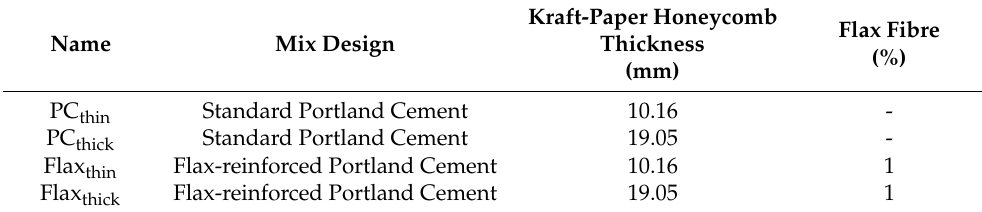
Table 2. Composition of kraft-paper honeycomb samples.